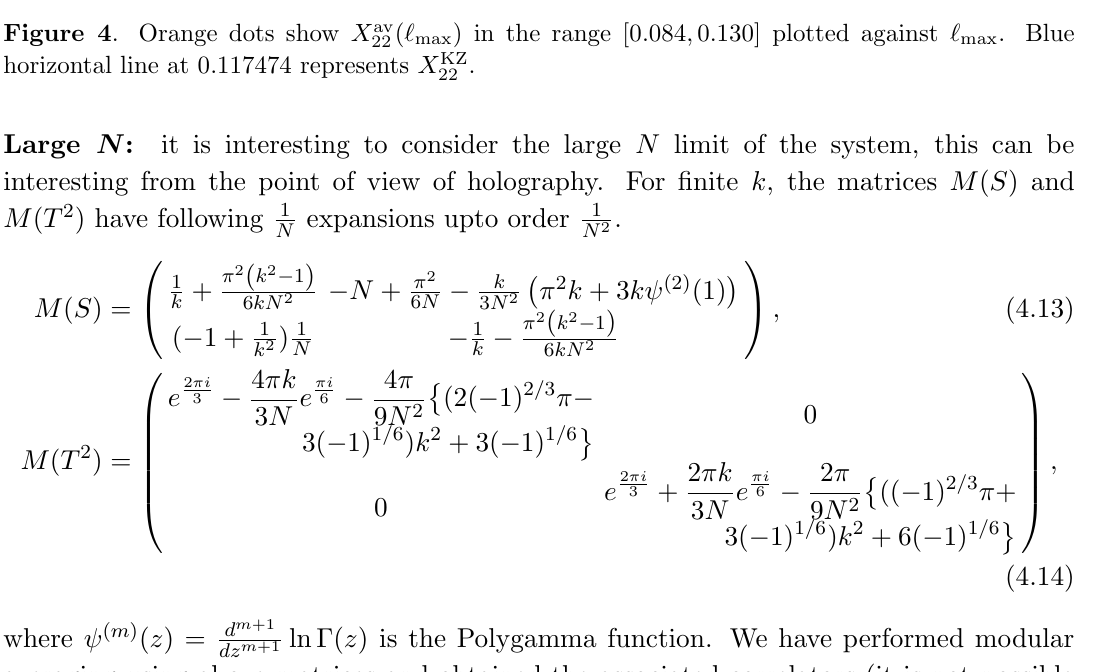
Figure 4 . Orange dots show X av horizontal line at 0 : 117474 represents X KZ